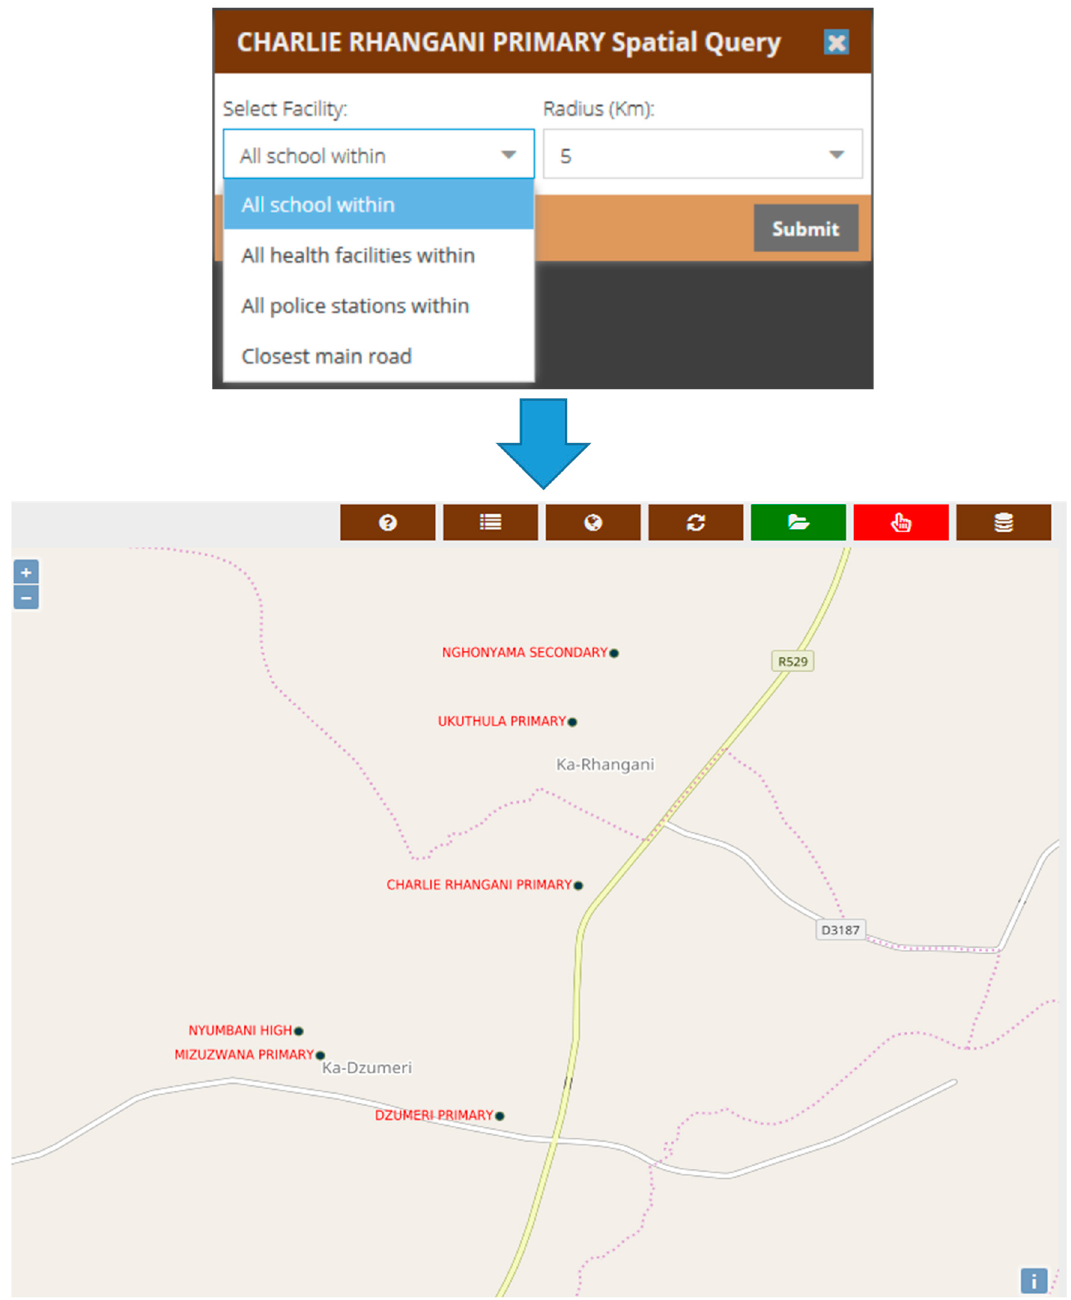
Figure 21. Buffering schools within a 5 km radius of Charlie Rhangani Primary. Figure 21. Bu ff ering schools within a 5 km radius of Charlie Rhangani